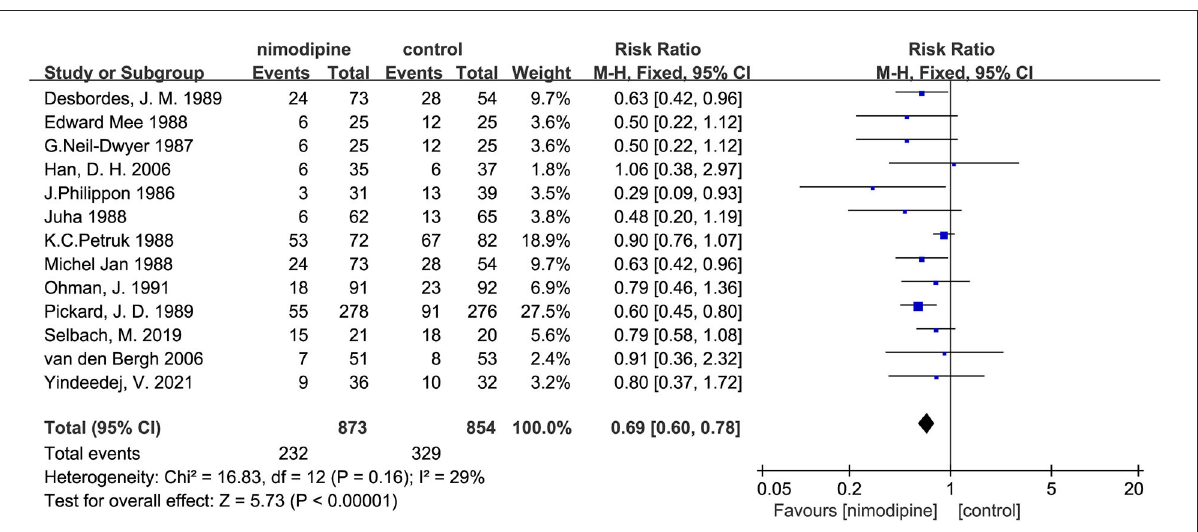
FIGURE4 Efficacy of nimodipine-use in the prevention of poor outcome in SAH